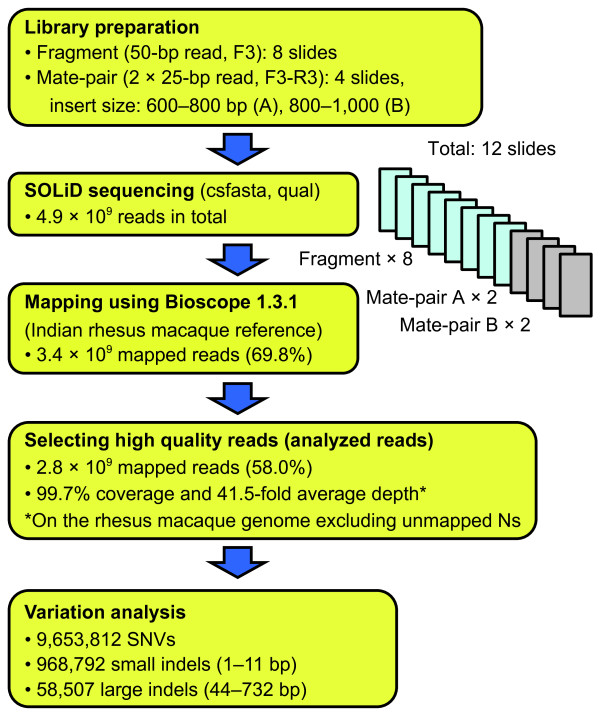
Overview of the Malaysian cynomolgus macaque genome sequencing and analysis. Fragment runs of eight slides and mate-pair runs of four slides (insert size: two slides for 600 to 800 bp and two slides for 800 to 1,000 bp) were performed on the SOLiD 3 Plus System. In total, 4.9 × 109 sequence reads were generated and mapped on the reference genome. After the high-quality reads were selected, single nucleotide variants (SNVs) and indel analyses were conducted.